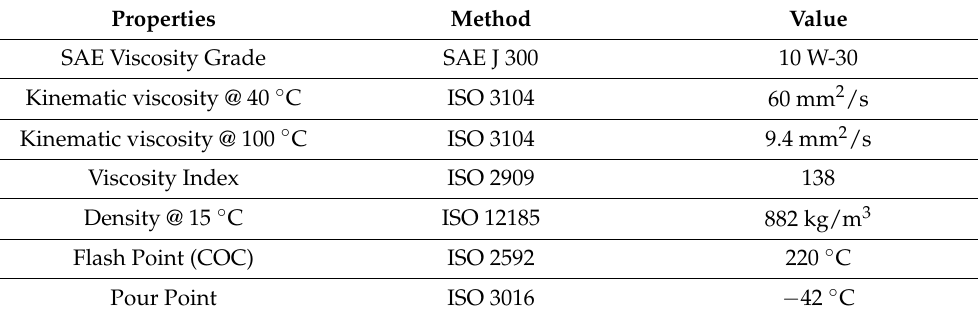
Table 2. Properties of the test lubricant.